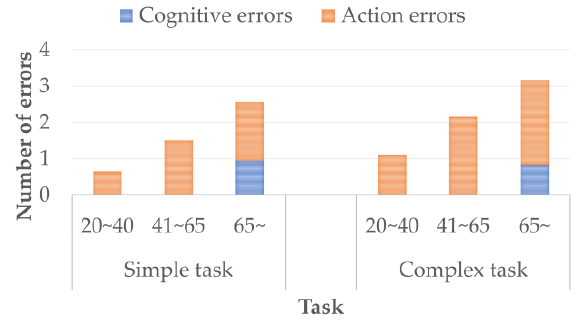
Figure 11. The number of dual task performances is shown by age group. Table 3. The left foot characteristics of few errors and many errors groups in action errors when older drivers perform dual task.